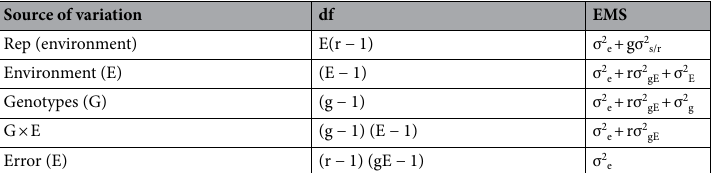
Table 5. Sketch of ANOVA table and EMS for pooled locations and seasons. EMS expected mean squares, df degree of freedom, r number of replication (3), g number of genotype (30), E number of environment